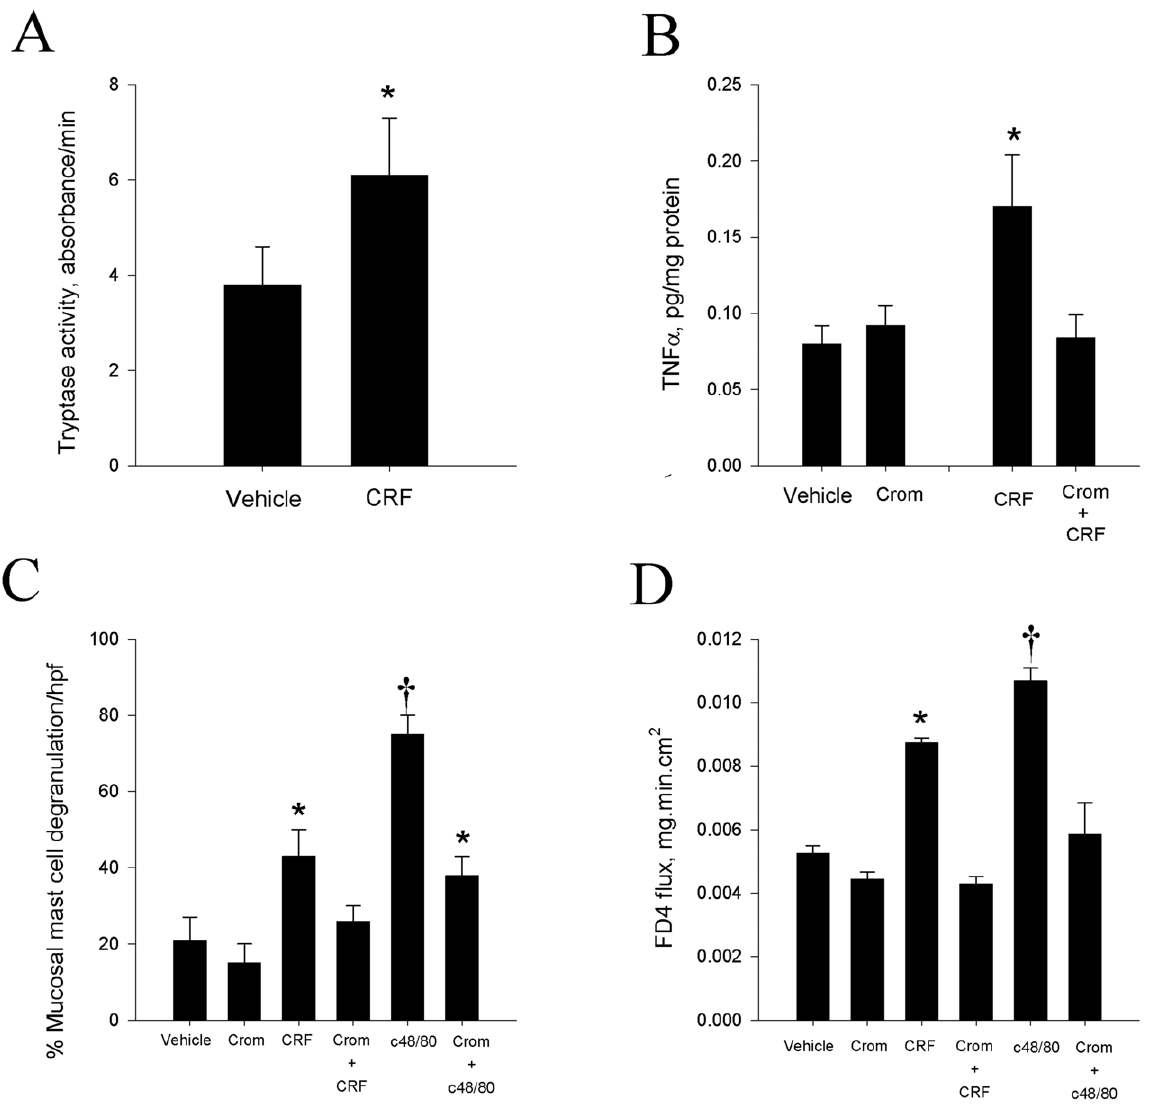
Figure 6. The role of mast cell activation in CRF-mediated changes in FD4 flux. Treatment of porcine ileal tissues mounted on Ussing chambers with CRF increased mast cell degranulation indicated by the increased percentage of degranulated mast cells (C) and the increased release of mast cell tryptase (A) and TNF- a (B). Treatment of porcine ileal tissues with cromolyn sodium 30 minutes prior to exposure to 0.5 m M CRF blocked mast cell degranulation (C) and TNF- a release (B) and prevented CRF-mediated increases in FD4 permeability (D). c48/80 (5 m g/mL) induced marked degranulation of mast cells (C) and increases in FD4 flux (D) that were inhibited with sodium cromolyn. Data for each FD4 flux experiments are expressed as means 6 SE for n=6 2 8 pigs. Symbols (*, { ) differ from other treatments by p , 0.05;